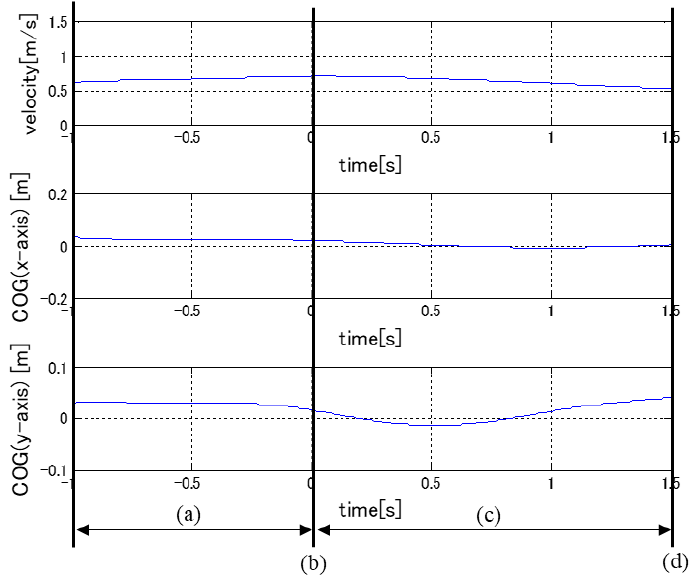
Figure 4. Example of experimental data. (a) Before turning, (b) Start of turning, (c) During turning, (d) End of turning.